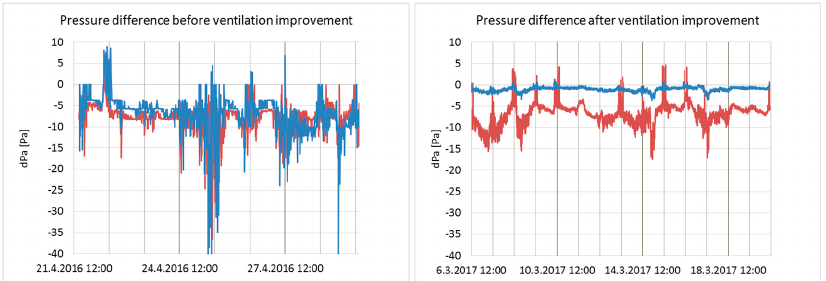
Figure 5. Pressure differences across the envelope in Classrooms 1 (red) and 2 (blue) before and after the ventilation improvement. the ventilation